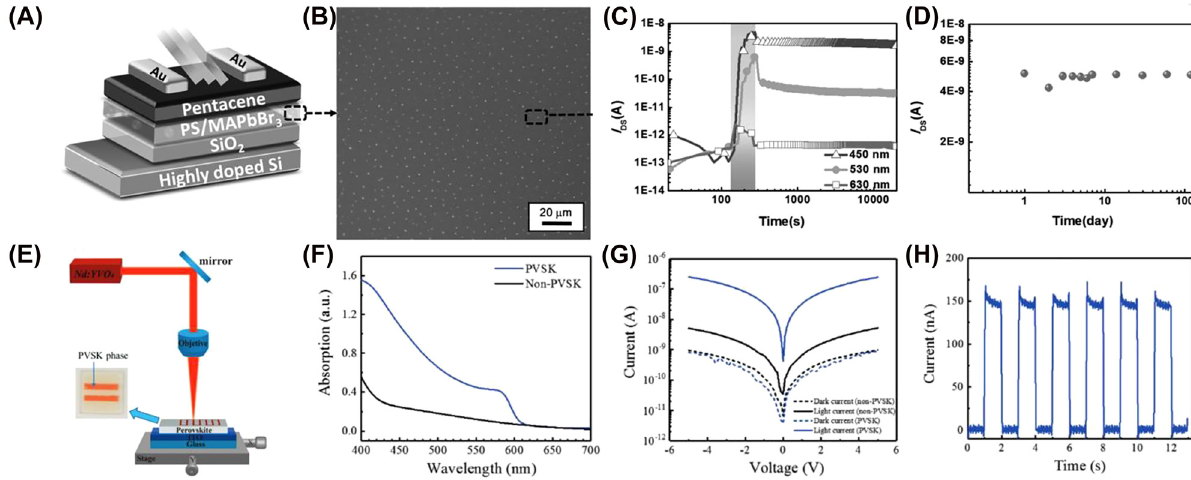
Figure 6: Perovskite-based photomemory devices. (A – D) An organic – inorganic hybrid perovskite-based photomemory device that exhibits multilevelmemorybehavior[76].(A)Structuralschematicofthebottom-gate,top-contactdevice.(B)ZoomedinSEMimageoftheMAPbBr 3 /PS composite fi lm. (C) The device ’ s distinctive current response to excitation wavelengths 450 , 530, and 630 nm. (D) Long and stable retention for 120 days. (E – H) Photomemory device based on phase-change perovskite CsPbIBr 2 [77]. (E) Setup for laser direct writing to pattern the non-PVSK phase (transparent in inset) to the PVSK phase (orange in inset). (F) Optical absorption spectrum of the PVSK (blue) and non-PVSK (black) phases. (G) I – V curves showing device response under dark and white light illumination. (H) Real-time measurement of device switching